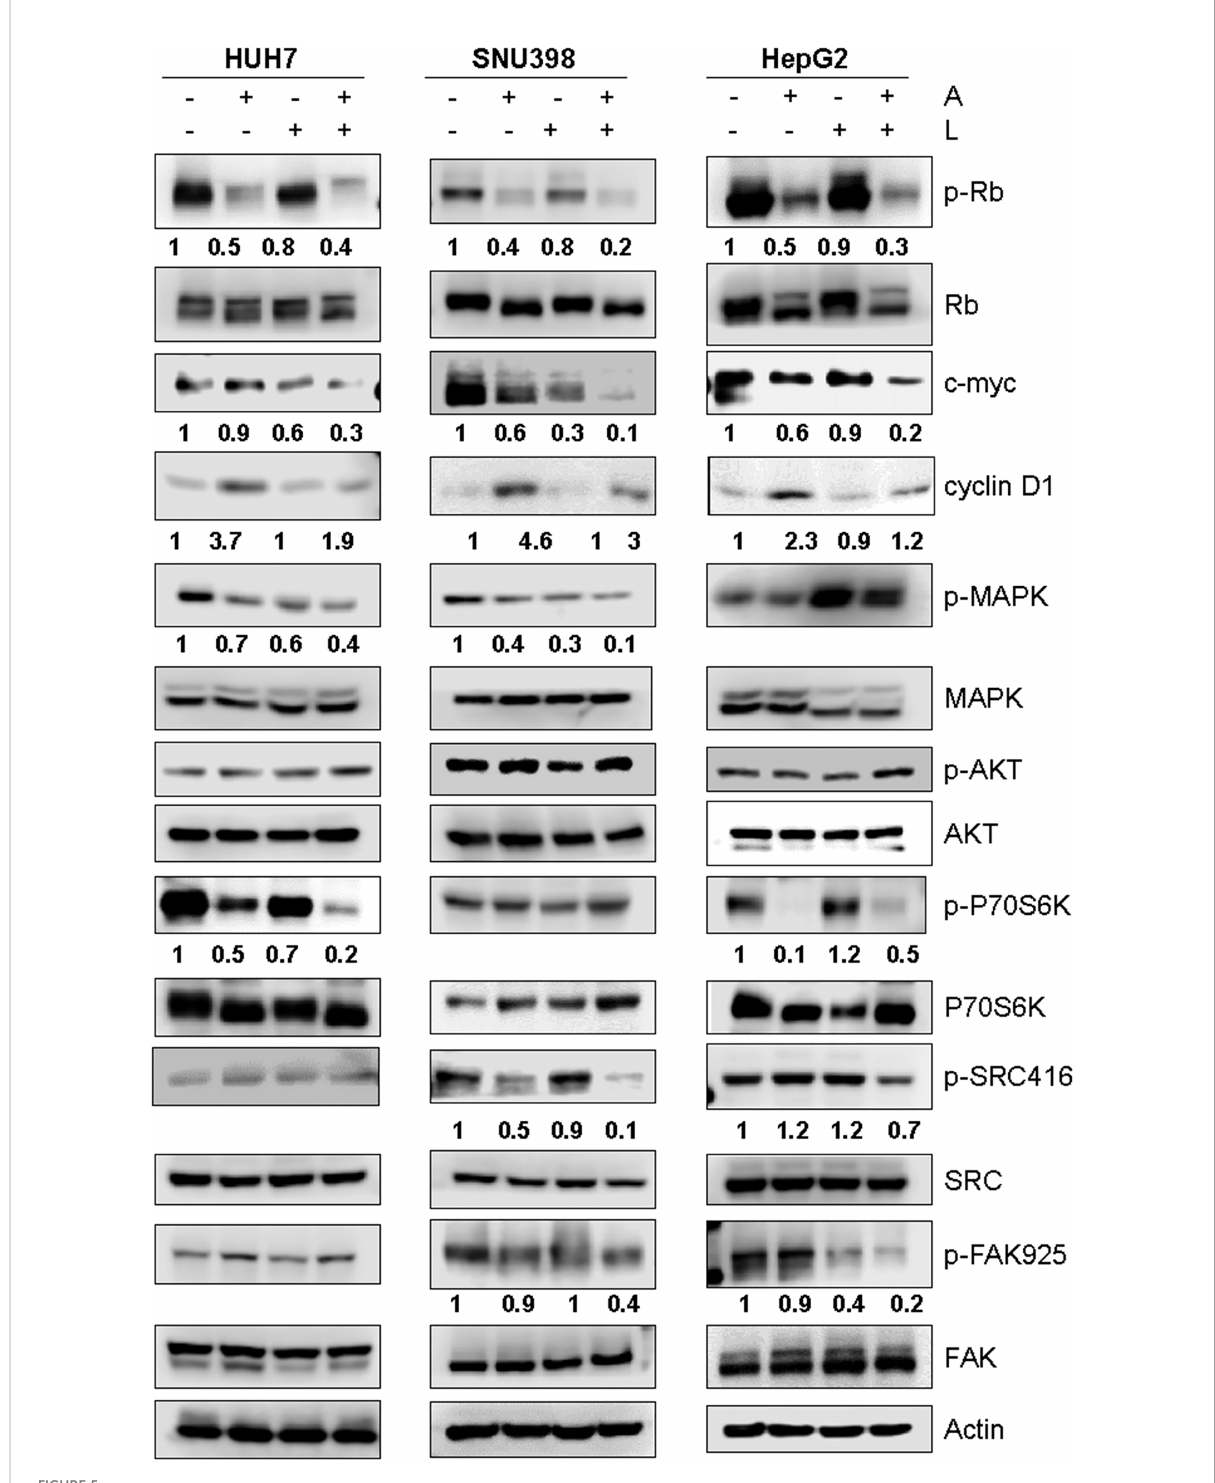
FIGURE 5 Effects of the simultaneous combination of abemaciclib and lenvatinib on intracellular signaling pathways. Cells were treated with 1 m M A and 0.5, 2, or 6.5 m M L for HUH7, SNU398, and HepG2, respectively, alone or in combination for 24 h. The cells were lysed and the expression of the indicated proteins was evaluated by Western blot analysis. Data are representative of two independent